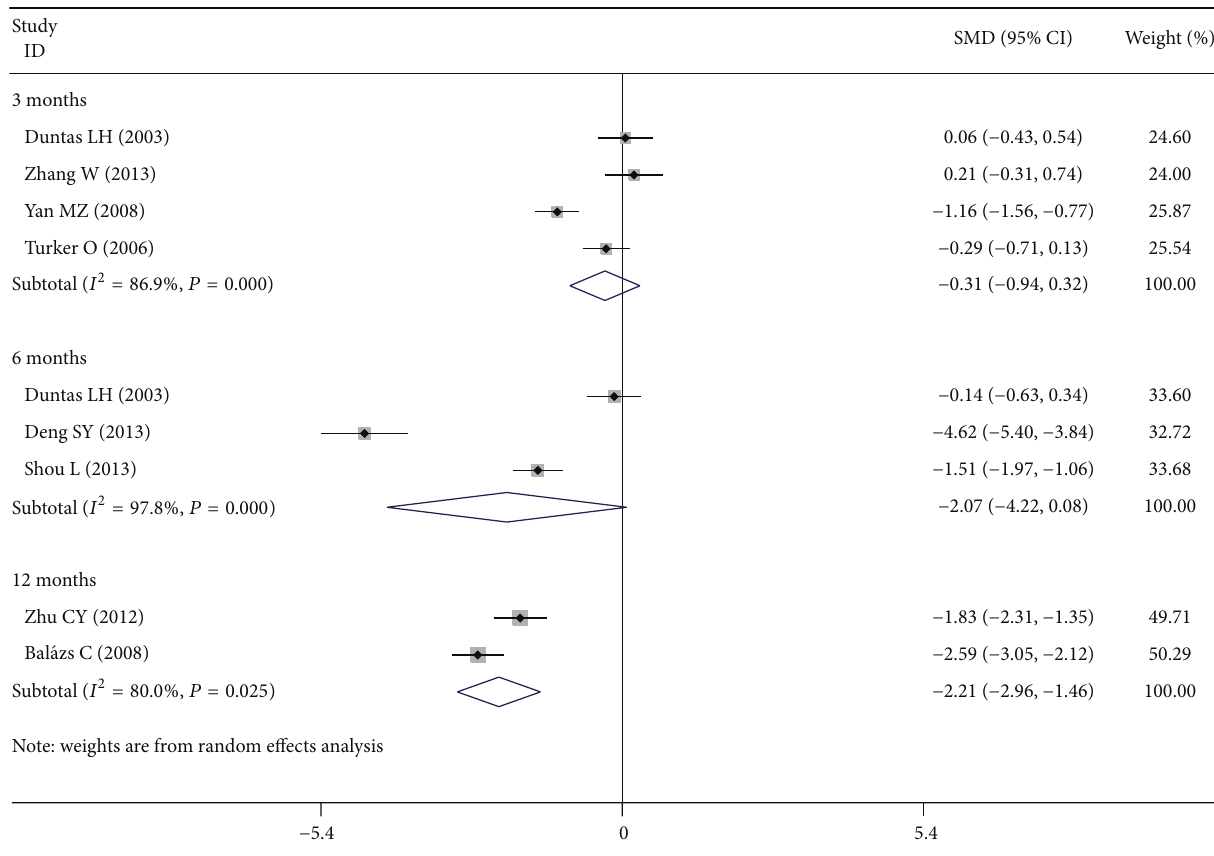
Figure 3: Forest plot showing the effects of Se supplementation on TgAb titers in patients of AIT.